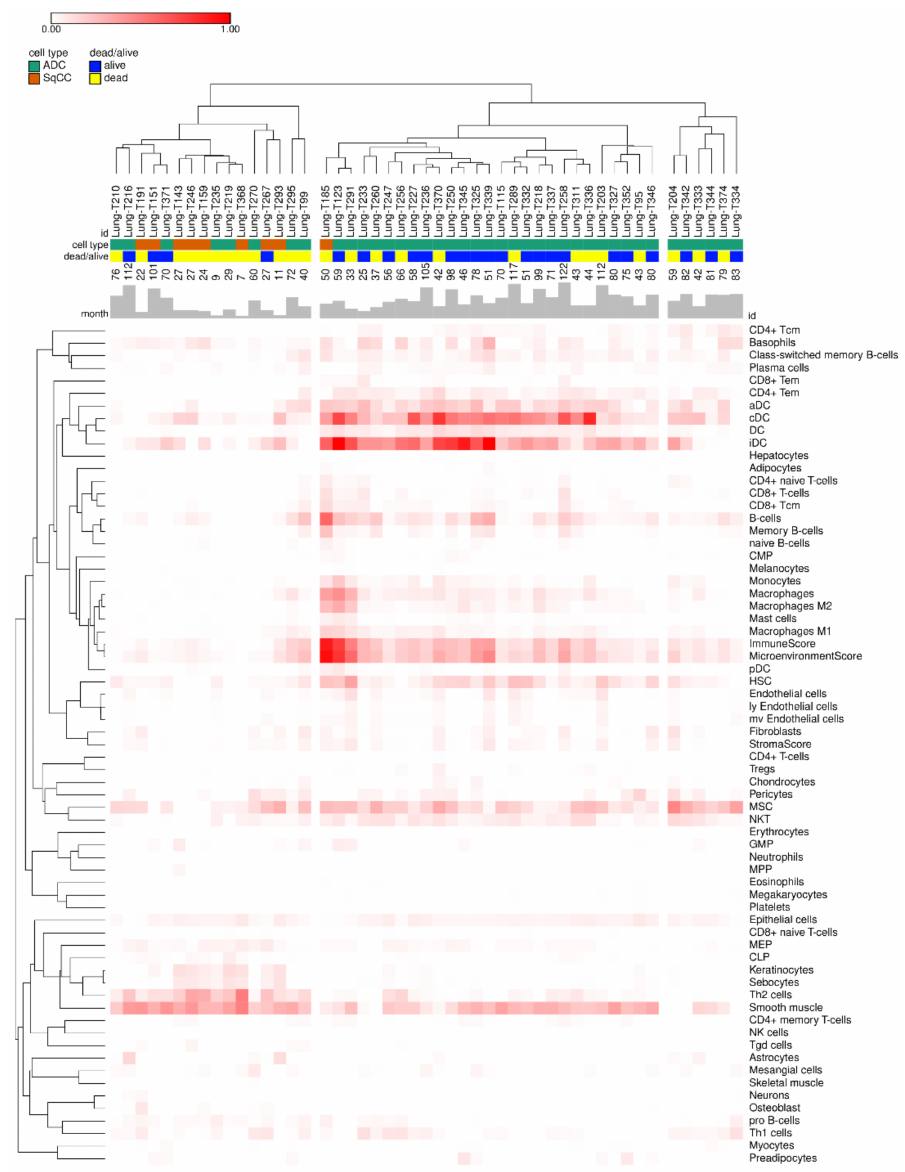
Figure 2. Heatmap showing the 64 cell types found across all samples. Columns are sample id and annotated tissue type with adenocarcinoma (ADC, green) and squamous cell carcinoma (SqCC, orange), survival status with dead (yellow) and alive (blue), survival/follow-up time in month with bar plot. Rows are cell/summary score categories from xCell. Values in heatmap plot are xCell score of each category and samples, and the color map is from white (0) to red (1). Hierarchical clustering was performed with pearson correlation for sample distance calculation and linkage method is “average” on web tool (https://software.broadinstitute.org/morpheus/, accessed on 16 August 2021). The three clusters were generated from manually determined distance